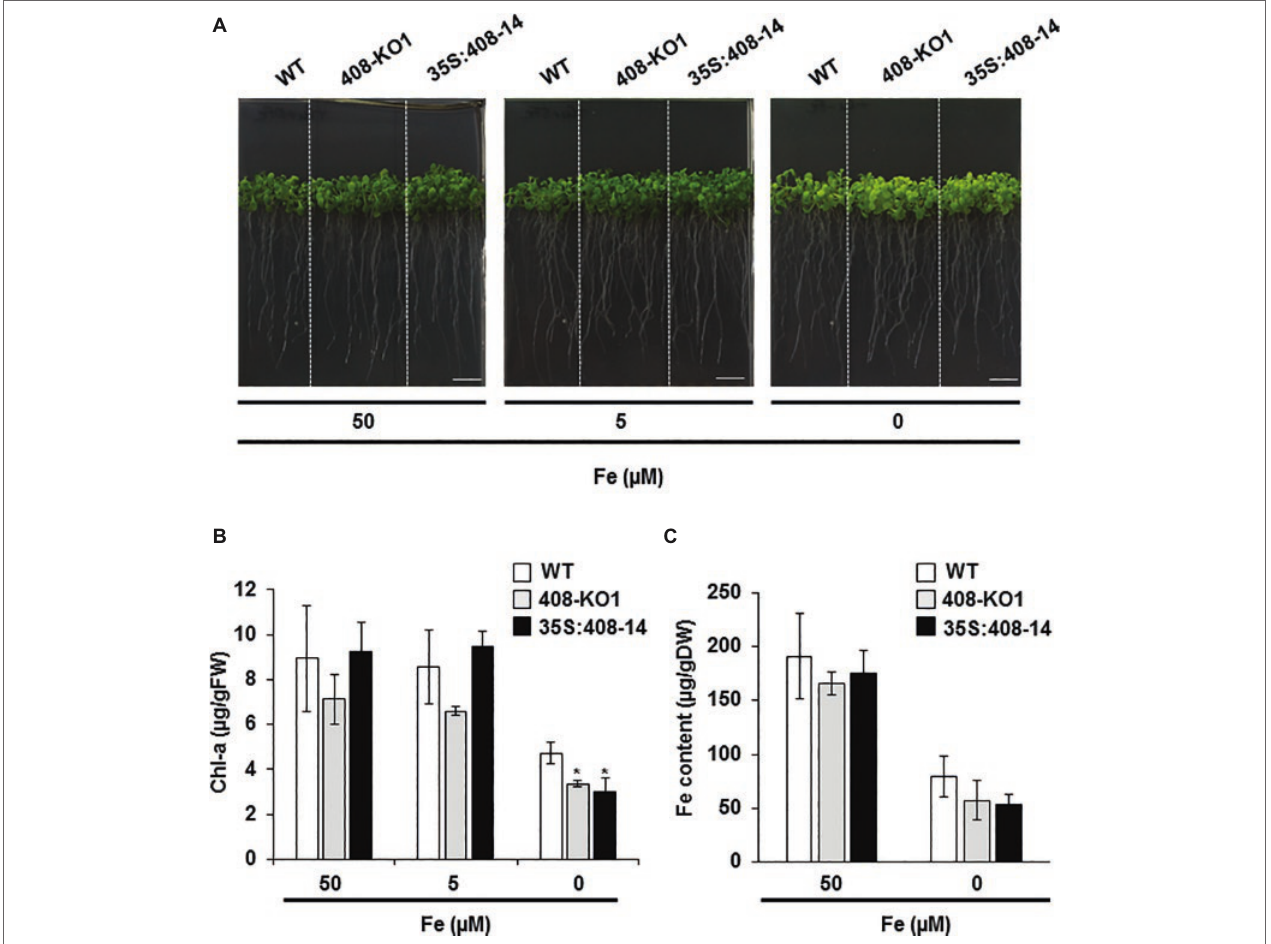
FIGURE 1 | Phenotypic characterization under iron deficiency of the seedlings with altered miR408 expression. (A) Photographs of representative 15-day-old seedlings grown on 1/2 MS plates containing 50, 5, and 0 μ M Fe citrate. (B) Chlorophyll-a content and (C) iron content in aerial tissues measured from the wild-type (WT), 408-KO1, and 35S:408-14 seedlings grown under the same conditions as indicated in panel A. Bars represent the means ± standard deviation of three biological replicates of n ≥ 15 plants for each genotype. Asterisks denote statistical differences ( p < 0.05) compared to the WT value according to the Duncan